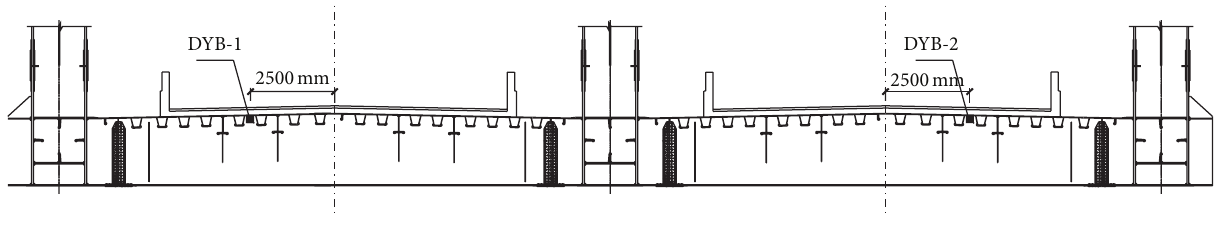
Figure 3: Layout of dynamic strain gauges on the steel deck.